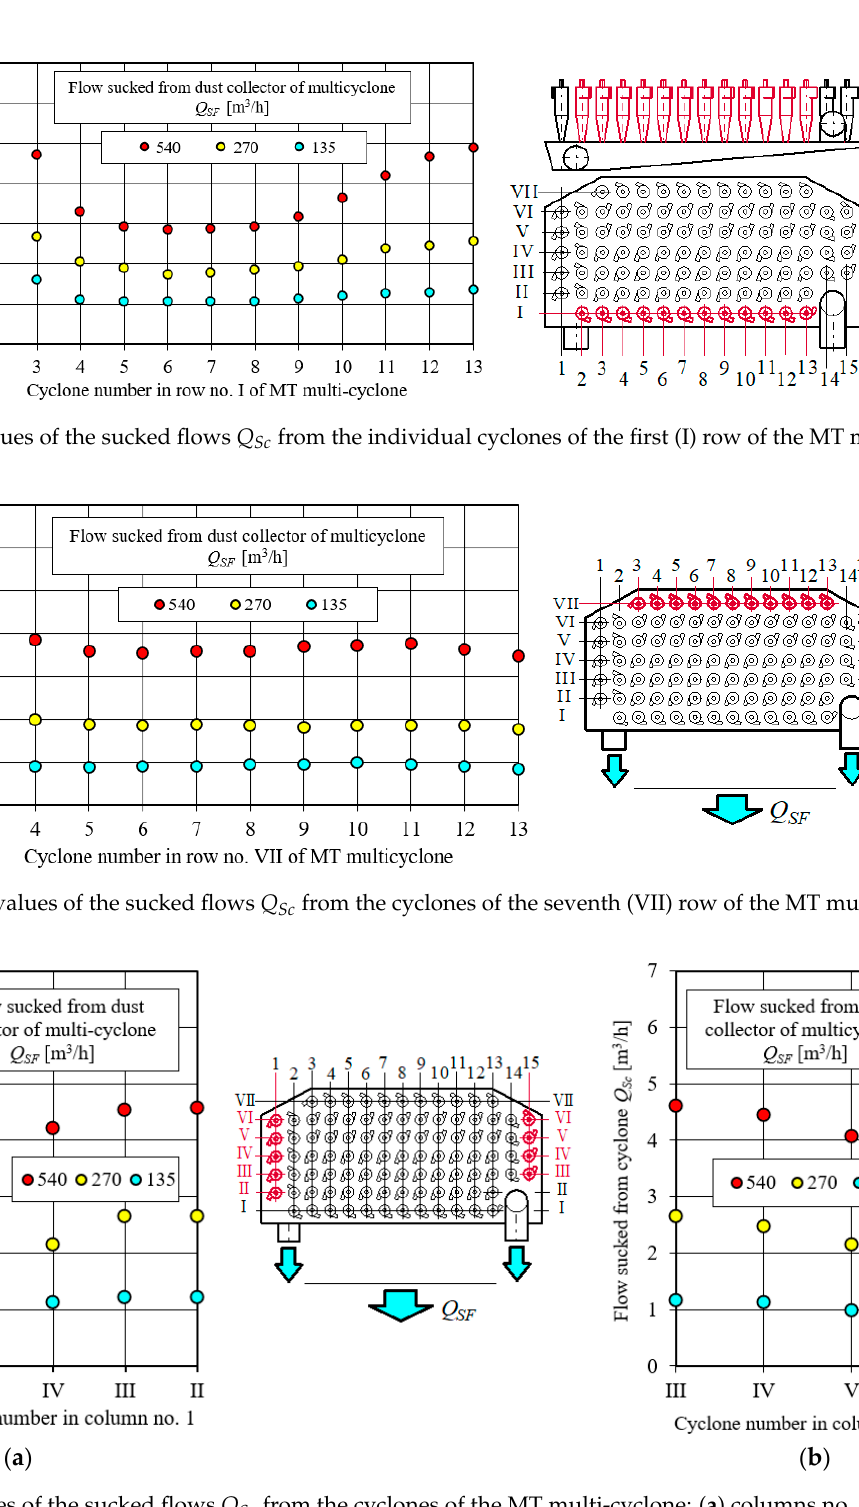
Figure 26. The values of the sucked flows Q Sc from the cyclones of the MT multi-cyclone: ( a ) columns no. 1, ( b ) columns no. 15.